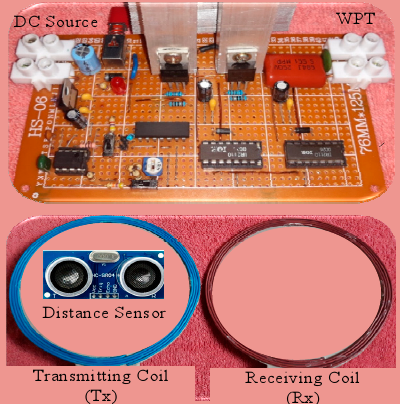
Figure 9. Experimental prototype for estimating coefficient of coupling.